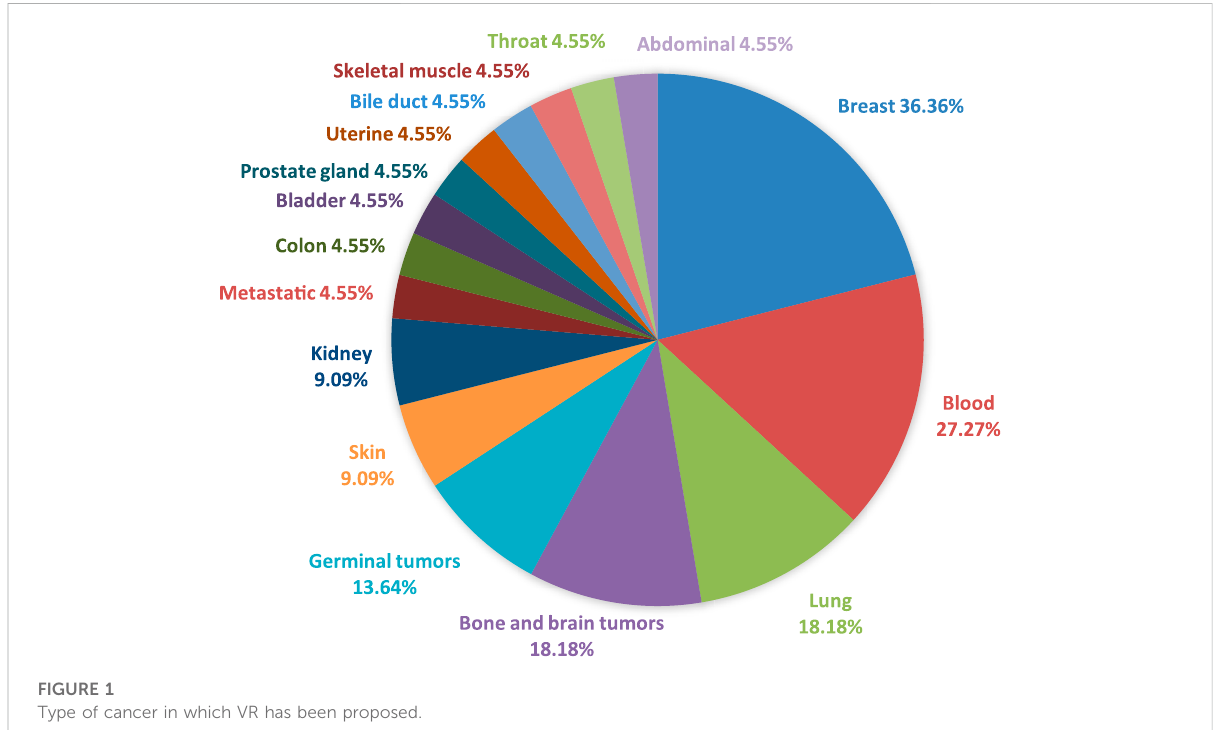
FIGURE 1 Type of cancer in which VR has been